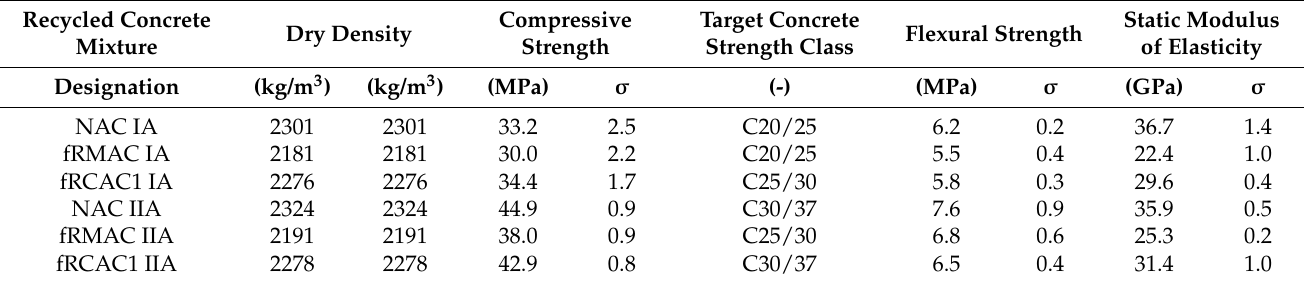
Table 3. Average values and standard deviation of evaluation of density and mechanical properties of concrete at age of 28